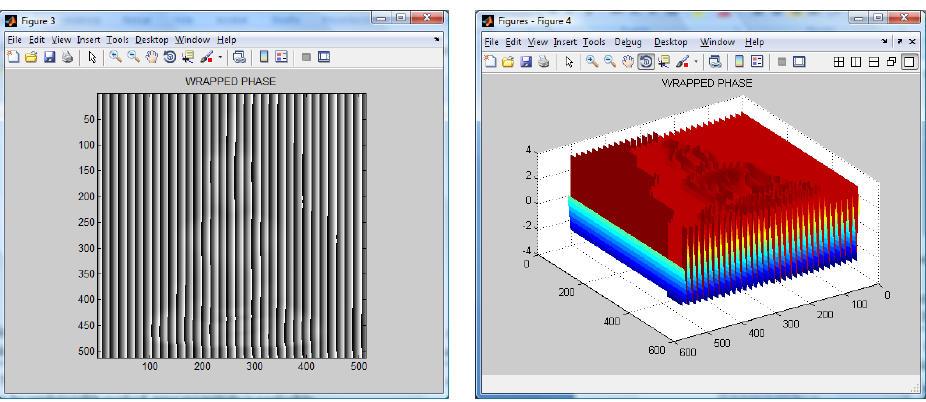
Figure 9. Wrapped phase (image and mesh).